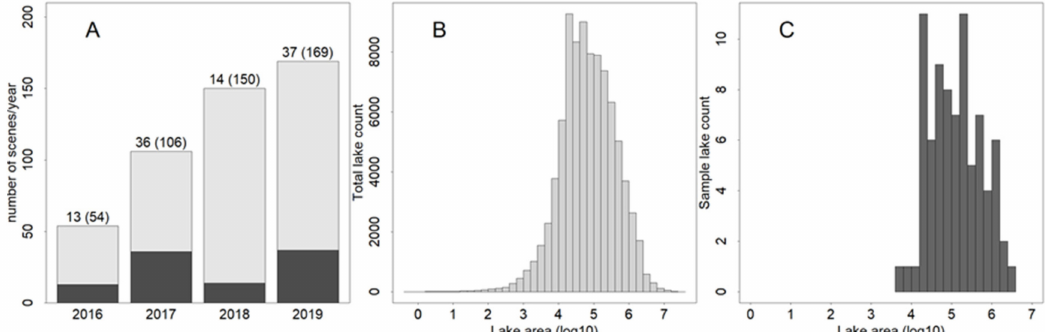
Figure 4. Sample statistics (dark) versus the whole dataset (bright): ( A ) number of sample scenes per year compared to the total number of scenes per year; numbers above bars indicate sample number (total number); ( B ) distribution of lake sizes for the whole dataset; ( C ) same as ( B ), only for the sample dataset.